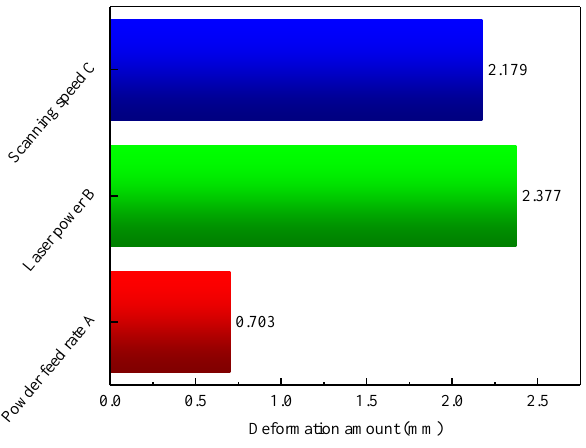
Figure 6. The range of each factor.